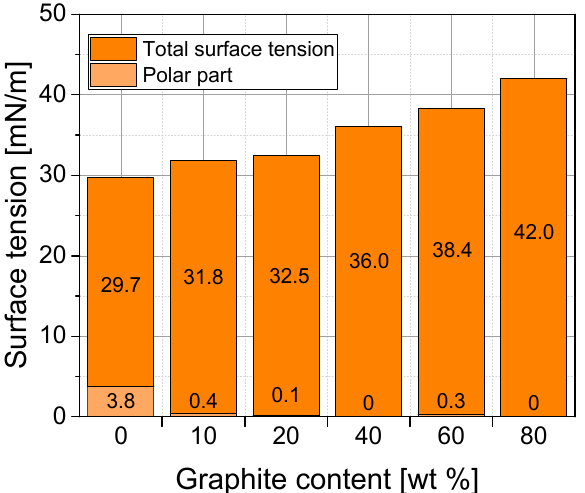
Figure 5. Surface tension and its polar part of PP/graphite composites with different graphite content.